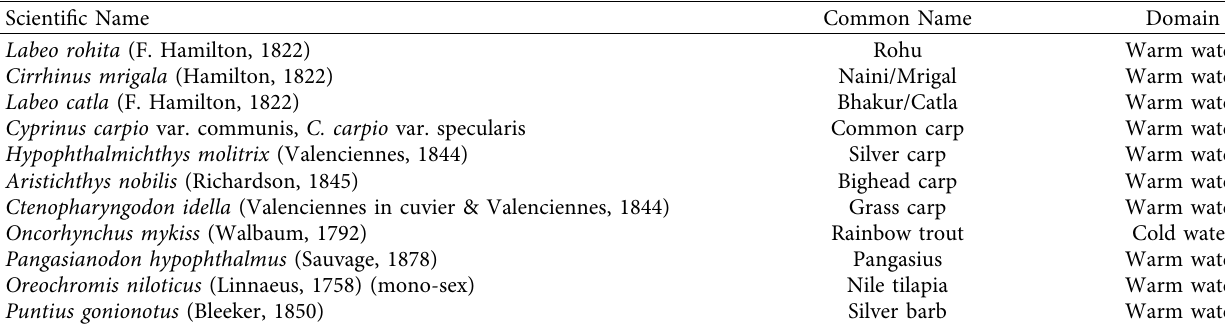
Table 3: Species that are technically recommended to the rear for commercial purposes in Nepal.